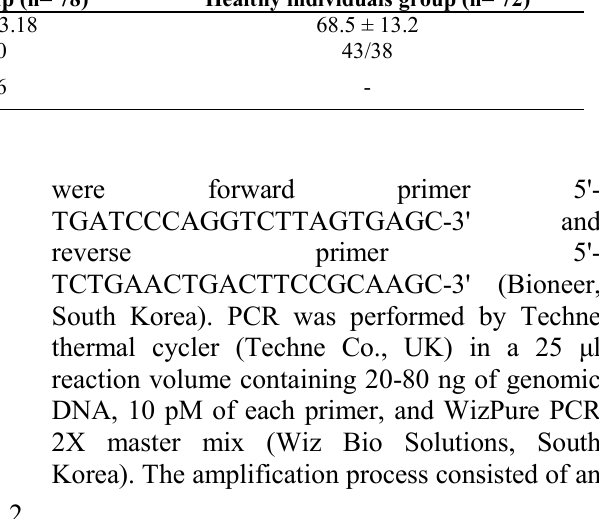
Table 1. Demographic characteristics of patients and healthy individual's groups contributing this study